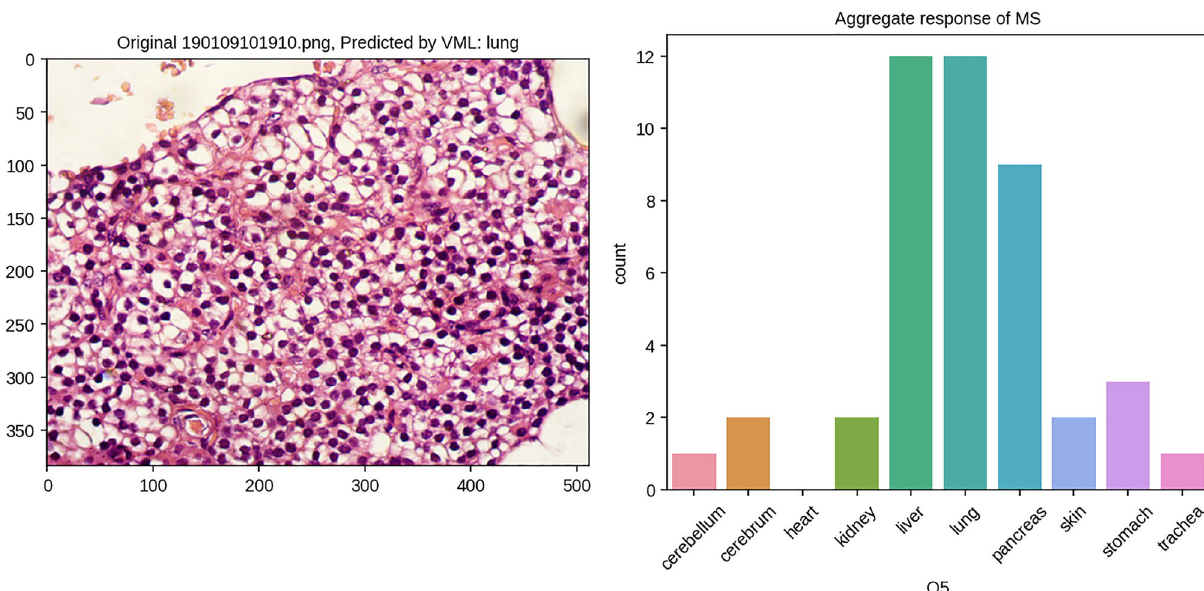
Figure 15. Parathyroid tissue predicted by VML & IML to be ‘lung’; the opinion of medical students is split between several classes (Figure generated by Matplotlib python library, version 3.3.4, https:// matpl otlib.